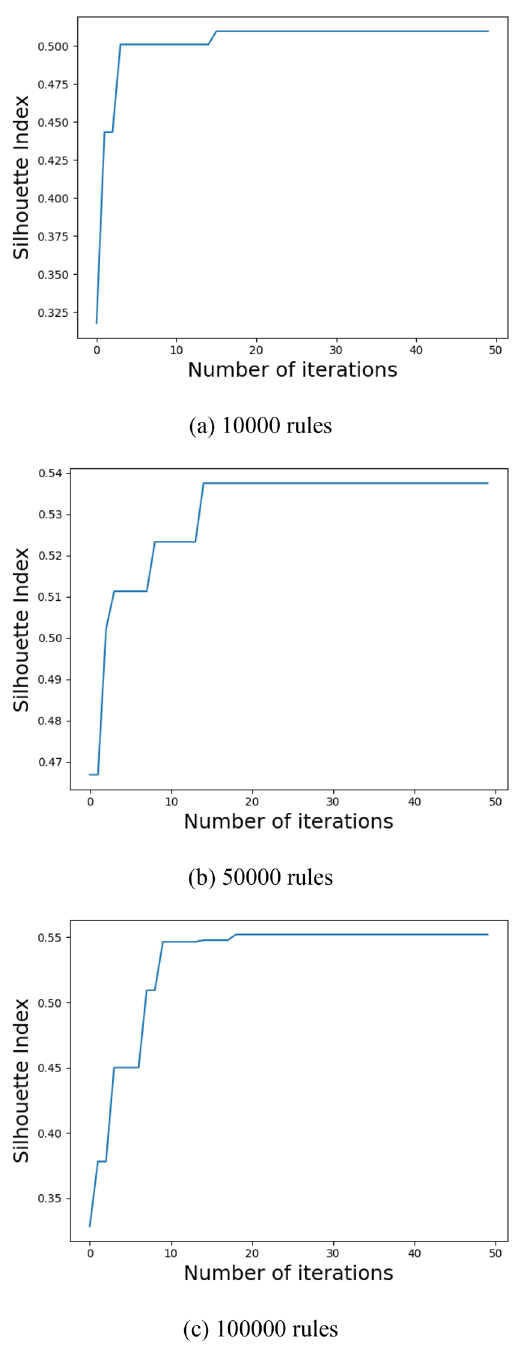
Figure 9. Parameter optimization on LMS policy